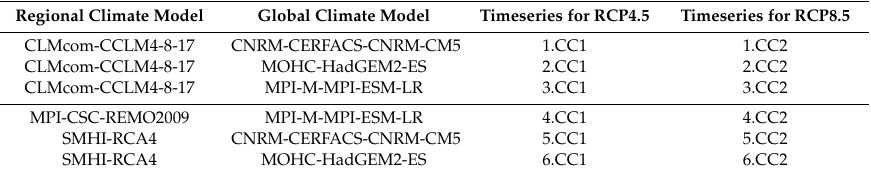
Table 4. Climatic